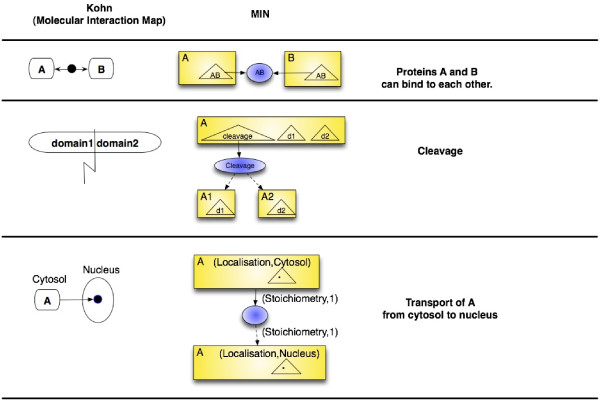
Examples of Kohn Maps building blocks and their MIN representations.